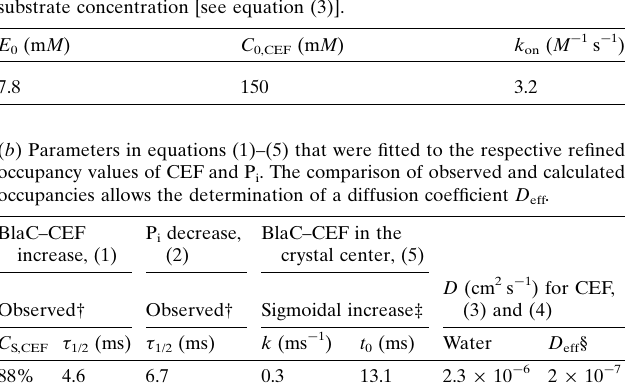
Table 5 Characterization of BlaC–CEF complex formation in